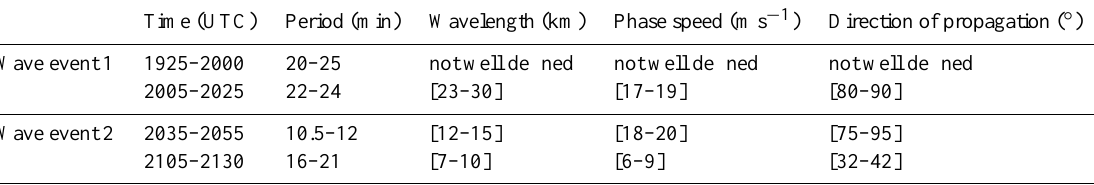
Table 3. Gravity waves parameters evaluated from filtered surface pressure records of three microbarometers. Uncertainty is indicated inside brackets (range of values). Note how uncertainty is lower for wave event 2.